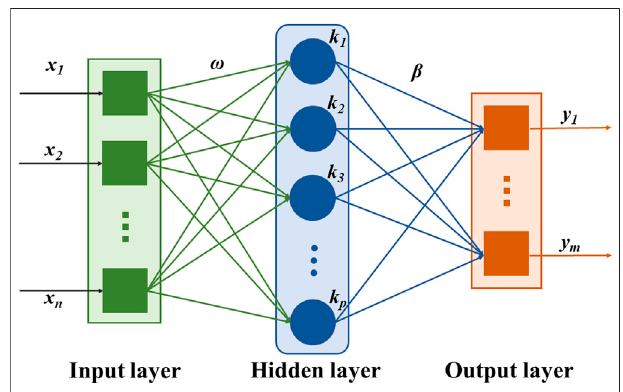
FIGURE 1 | Structure of single hidden layer neural